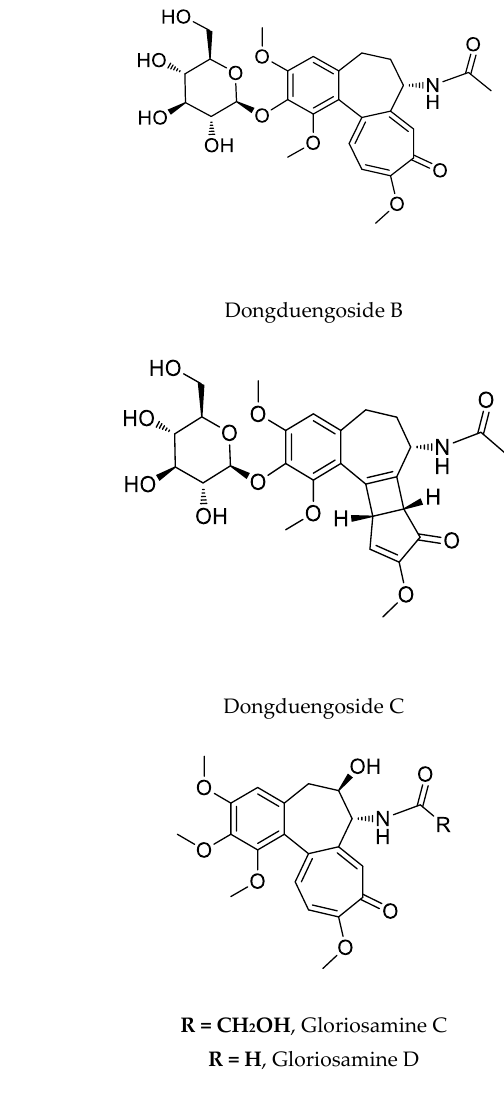
Figure 1. Notable compounds, isolated from Astragalus and Gloriosa species. Table 2. Notable metabolites from wild and in vitro cultures of targeted species and cytotoxicity of some on a panel of malignant